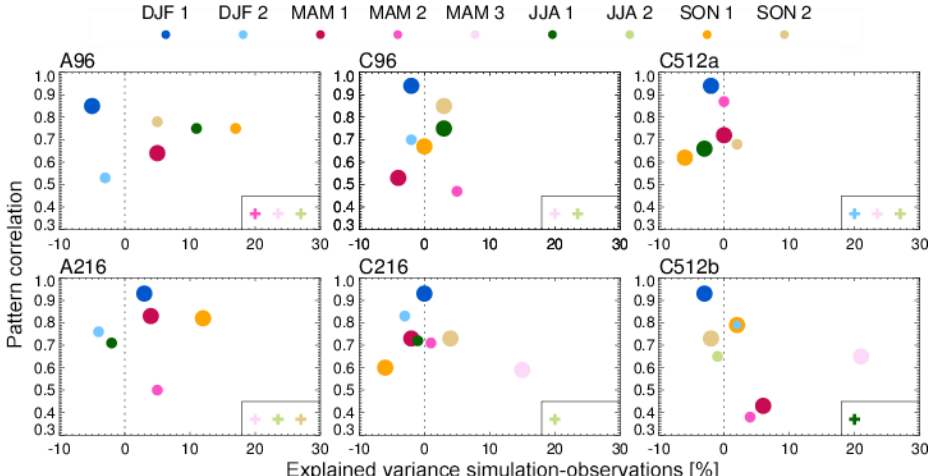
Figure 13. Observed patterns a simulation was able to produce (circles) and the ones that it missed (crosses). For patterns that could be reproduced, the y axis gives the pattern correlation coefficient and the x axis shows the difference in the percentages of explained space–time variance. Large circles indicate that a simulated pattern is associated with a similar physical mechanism as in observations.